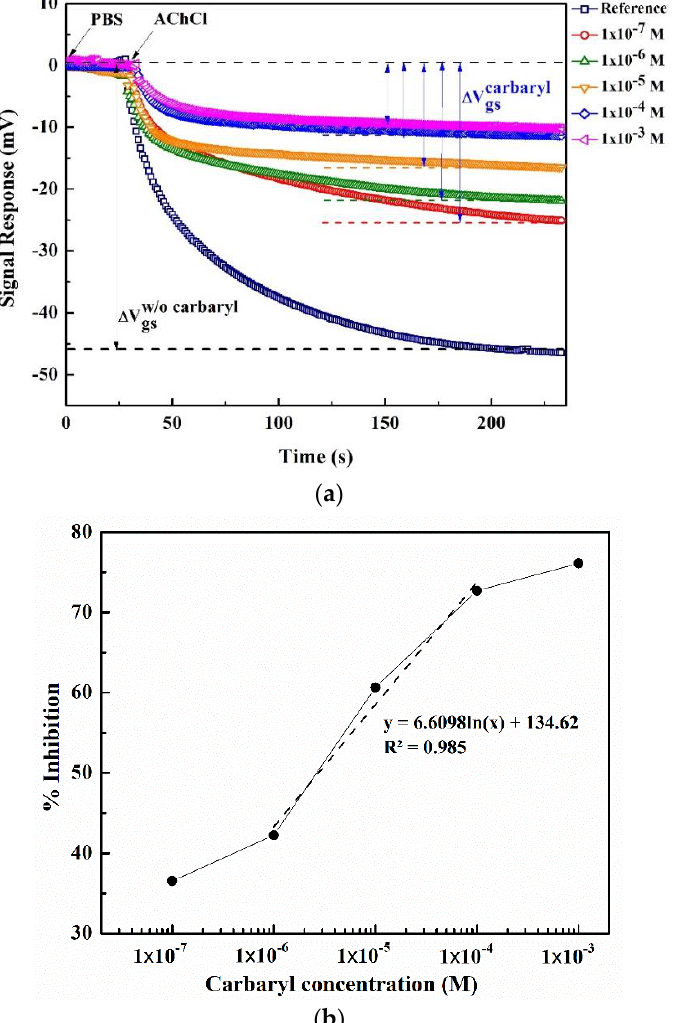
Figure 9. Carbaryl-induced AChE enzyme inhibition under variable carbaryl concentrations given 25 °C: ( a ) ISFET signal response without (ΔV gsw/o carbaryl ; reference) and with carbaryl (ΔV gscarbaryl ), ( b ) a corresponding percentage of AChE enzyme inhibition.